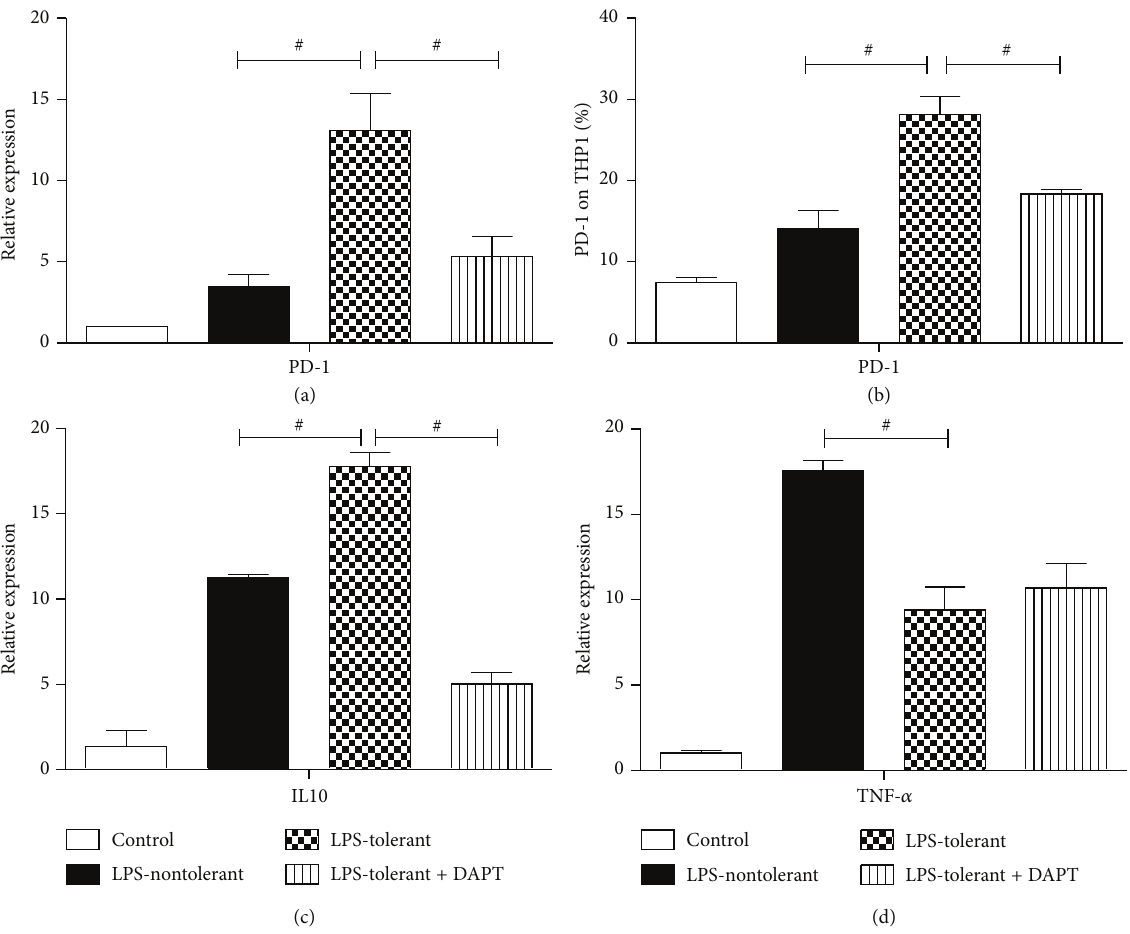
Figure 4: Notch inhibition by DAPT decreased PD-1 and IL-10 transcriptions in LPS-tolerant THP1 cells. LPS-tolerant THP1 cells were induced as mentioned above. In tolerant group, DAPT (40 𝜇 M) was added into the culture at the beginning of the treatment of LPS to inhibit the Notch signaling pathway. The mRNA levels of PD-1 (a), IL-10 (c), and TNF- 𝛼 (d) and protein levels of PD-1 (b) were examined in control, LPS-nontolerant, LPS-tolerant, and DAPT groups. Data are normalized to 𝛽 -actin mRNA and presented as 2 −ΔΔ CT . # 𝑃 value <